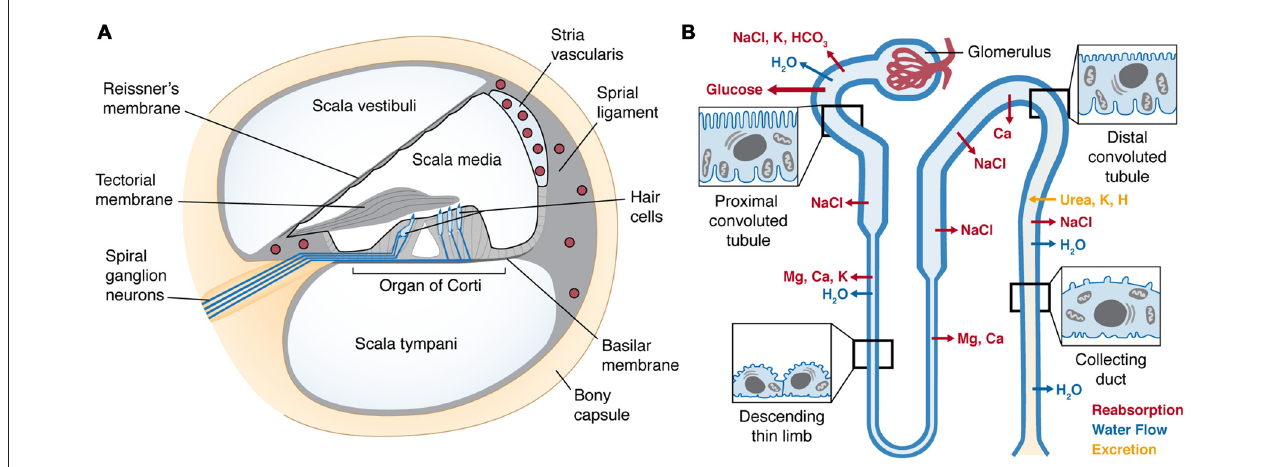
FIGURE 2 | (A) Cross-section of the cochlear duct, illustrating the perilymph-filled scala vestibuli and scala tympani, separated from the scala media by tight junctions between adjacent cells (black line) of Reissner’s membrane and reticular lamina of the organ of Corti resting on the basilar membrane. Within the organ of Corti are four longitudinal rows of sensory hair cells (in sky blue), under the tectorial membrane. The hair cells are innervated by afferent and efferent fibers (blue lines). Within the lateral wall of the cochlea is the highly-vascularized stria vascularis (upper right); enclosing several capillary beds (red circles) lined by tight-junction-coupled endothelial cells (black lines enclosing red circles) that form the cochlear BLB. (B) A nephron (kidney tubule) showing the glomerulus encapsulating a single capillary bed that gathers the ultrafiltrate from blood. The proximal tubule has a brush border of microvilli that recovers the majority of essential nutrients and ions, and the distal tubule recaptures the remaining nutrients, and excretes specific ions. Sites of major ion movements are shown. Both schematic diagrams are not to relative scale.